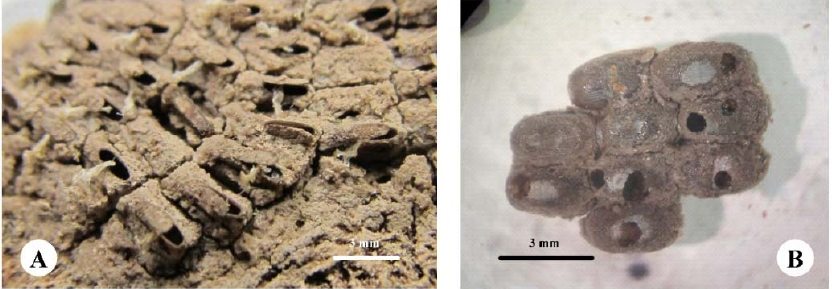
Figure 4. L. delicatula eggs with ( A ) normal hatching holes on the top and ( B ) O. kuvanae adult exit holes at the bottom.